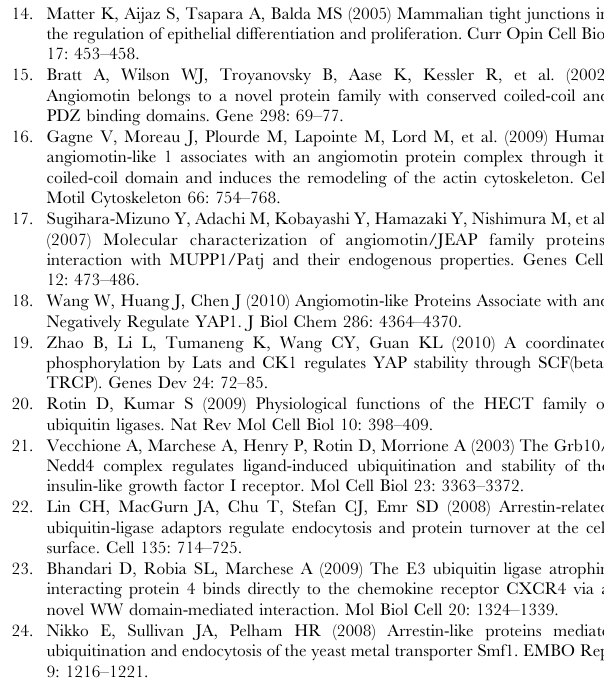
Figure S1 Domain structure of AMOTL1, YAP1 and Nedd4.2. WW domains in AMOTL1 and Nedd4.2 protein sequence are indicated with blue rhombs. c-c, coiled coli domains; P-rich, proline rich domains; C2, C2-domain; HECTc, Homol- ogous to the E6-AP Carboxyl Terminus domain. Figure S2 YAP1 protects AMOTL1 against Nedd4.2- mediated protein turnover. F.AMOTL1, and myc.Nedd4.2 were co-expressed with increasing amounts of V5.YAP1 (1 m g, 3 m g and 6 m g). Western blot analysis with anti-Flag revealed increasing AMOTL1 levels despite the presence of myc.Nedd4.2. Actin was used as a loading control. Figure S3 The WW1 domain of YAP1 is required for binding and stabilization of AMOTL1. A , Endogenous AMOTL1 was strongly precipitated by a mouse anti-YAP1 antibody. B , Immunostaining in HEK293T cells using anti- AMOTL1 and anti-YAP1 antibodies revealed that the two